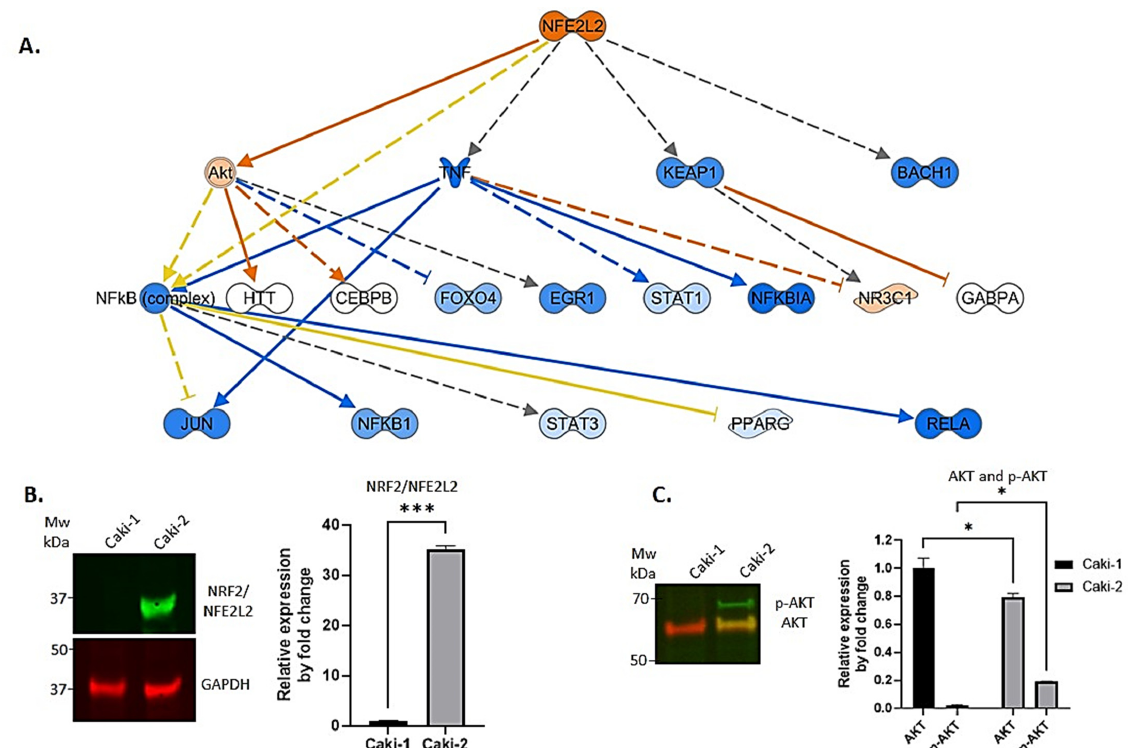
Figure 5. ( A ) Computationally generated IPA mechanistic pathway analysis network with plausible directional networks that are associated with the predicted activation of NRF2 (NFE2L2). In addition to NRF2 activation, among the targets that are predicted to be activated is AKT. As predicted, the immunoblot analysis demonstrates the activation and phosphorylation of AKT in Caki-2 cells but not in Caki-1 cells. ( B ) . Western blot analysis con fi rms the signi fi cant expression and upregulation of NRF2 in Caki-2 cells with a very low abundance of the protein detected in Caki-1 cells. ( C ). Activation of AKT is demonstrated by the signi fi cant increase in AKT phosphorylation in Caki-2 cells compared to Caki-1 cells. The pathway and network legends are identical to Figure 4. For the bar graphs, signi fi cant di ff erential expression pro fi les are depicted using asterisks corresponding to the following thresholds *( p < 0.05) and ***( p < 0.001).